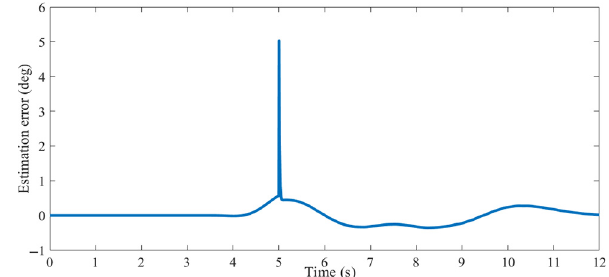
Figure 17 Fault estimation error curve of the rotation angle sensor by estimation method in this paper